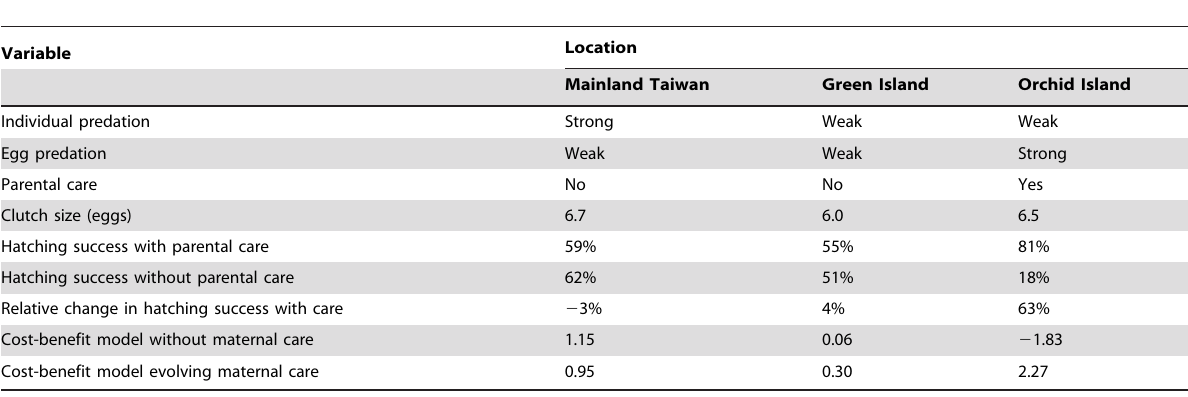
Table 1. Predation, competition, and parental care attributes of three long-tailed skink populations.